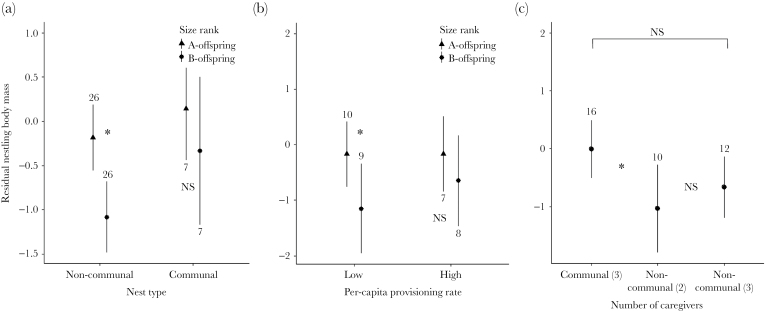
Interactions involving size rank and resource availability on residual nestling body mass (corrected for tarsus length, sampling time and date) in 2-nestling broods of the Seychelles warbler. (a) Influence of nest type on body mass according to size rank. (b) Influence of per-capita provisioning rate on body mass according to size rank. Note that per-capita provisioning rate was modeled as a continuous variable but grouped here or visual clarity. (c) Influence of additional caregivers in noncommunal nests. Noncommunal nests are split according to those that were provisioned by a helper-at-the-nest (caregivers = 3) and those that were provisioned only by the breeding pair (caregivers = 2) and both are compared to communal nests, which are always provisioned by 3 parents. Dots and lines denote mean and standard error respectively; numbers represent sample size per group. Significant (“*”) and nonsignificant (“NS”) interactions at P < 0.05 are displayed.